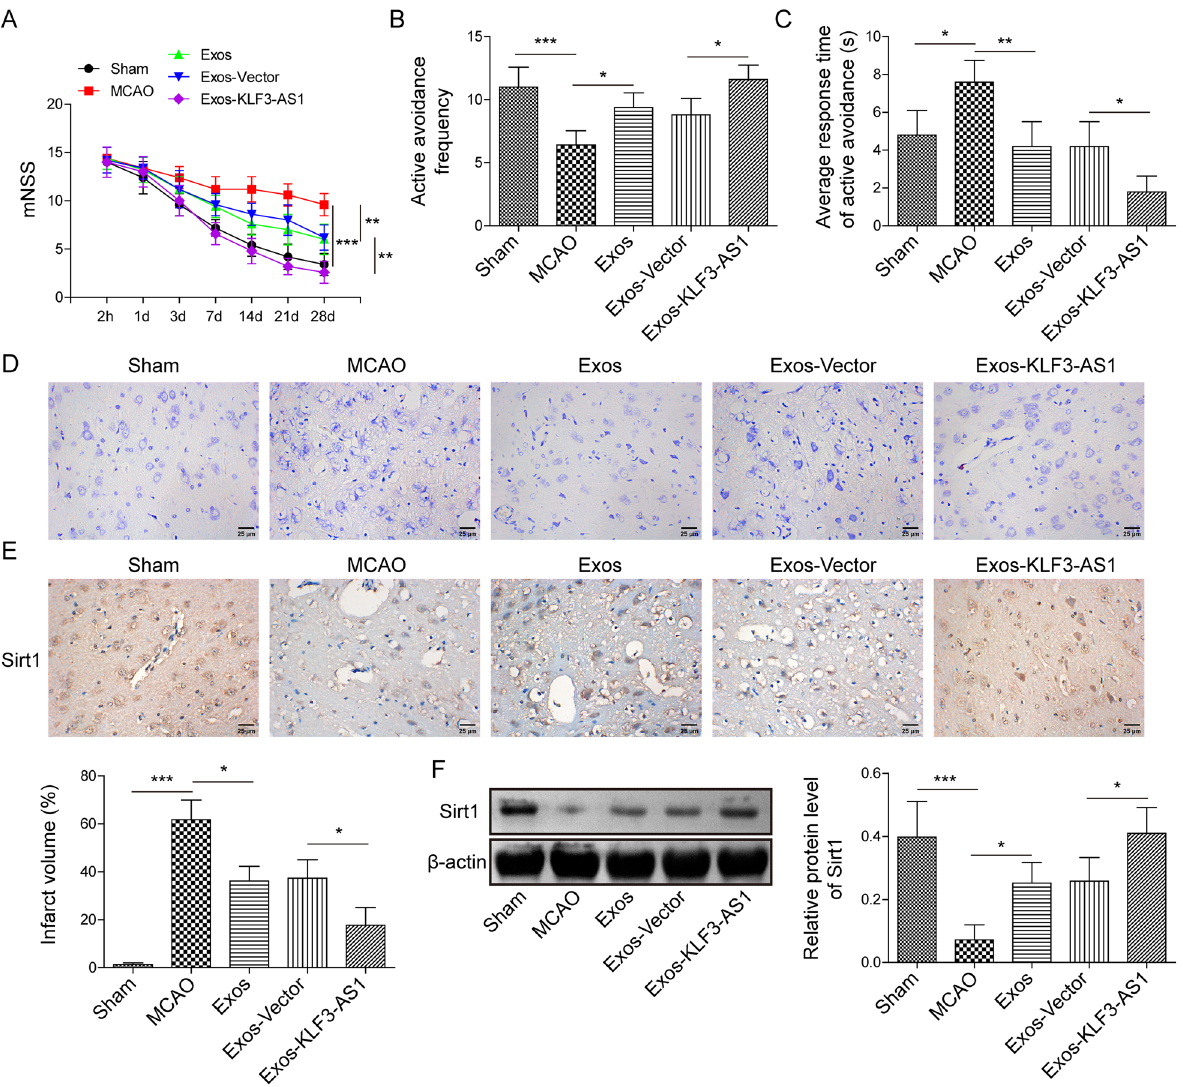
Fig. 1 The role of Exos-KLF3-AS1 in MCAO mice. Mice were subjected to MCAO surgery, followed by injected intravenously with sdyExos, Exos-vector or Exos-KLF3-AS1. A Neurological severity scores of mice. B , C The active avoidance behavior of mice by shuttle box test. D Infarct volume was calculated. Sirt1 expression detected by immunohistochemistry ( E ) and western blot ( F ). n mean SD. *P < 0.05, **P < 0.01, ***P < ±